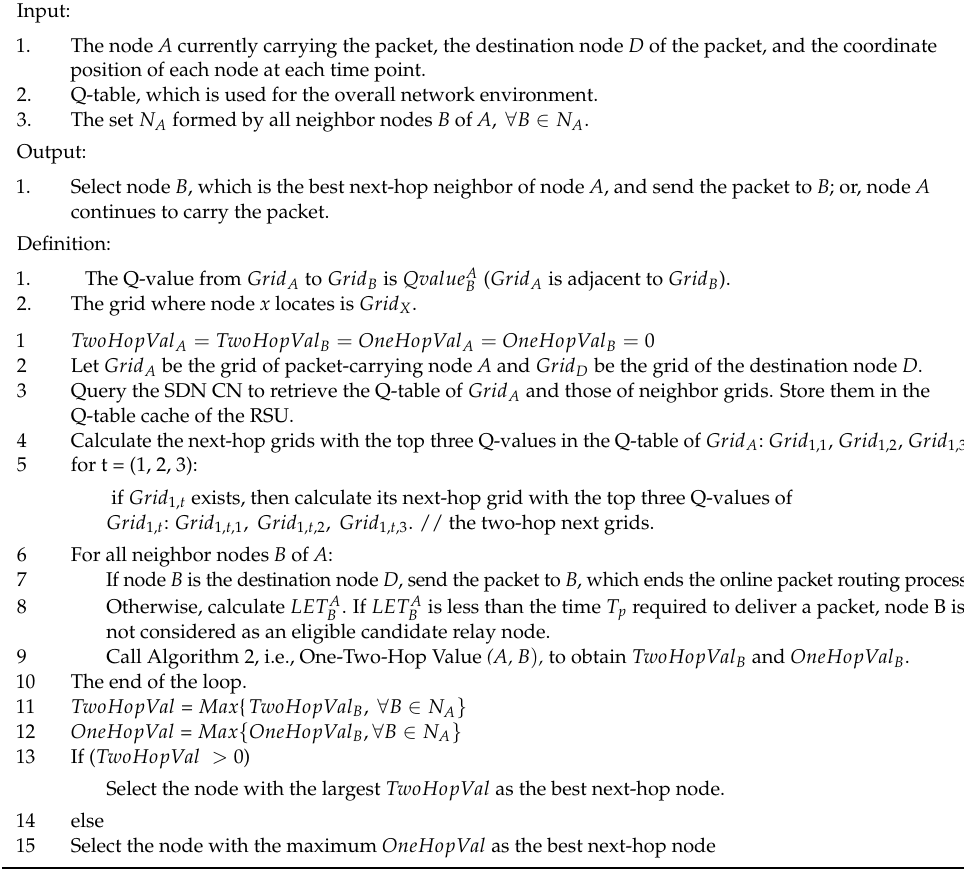
Algorithm 1. Next-hop node selecting